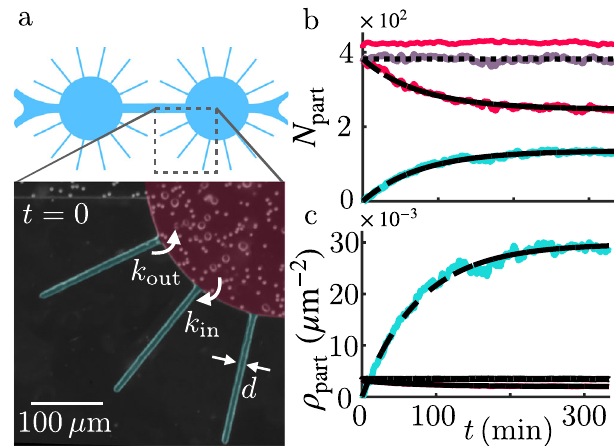
Fig.4|De-mixingofabinarymixture.a Schematicsanddetailsofthemicro fl uidic chamber: 200 μ m-radius circular chambers decorated with side channels of width d =7 − 8 μ m.Bothcells(2 R =8 − 10 μ m)andpolystyrenebeads(2 a =6 μ m)arevisible in the picture. b , c Time evolution of the number of particles and surface number densitywithinthe circular chamber ( N c , ρ c red solidline)and the sidechannels ( N s , ρ s cyansolid line) in presenceofthe microalgae. Within this time the total number of particles in the chamber remains constant (purple solid line). Dashed/dash-dot lines are a fi t to the fi rst orderkinetics(seeSupplementary Section 6).Dotted lines indicate the initial values of N c and ρ c . Dashed red line corresponds to the control experiment without